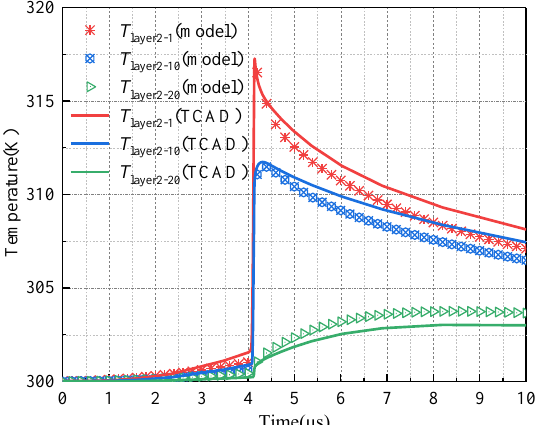
Figure 7. Temperature variation in sublayers during switching processes.